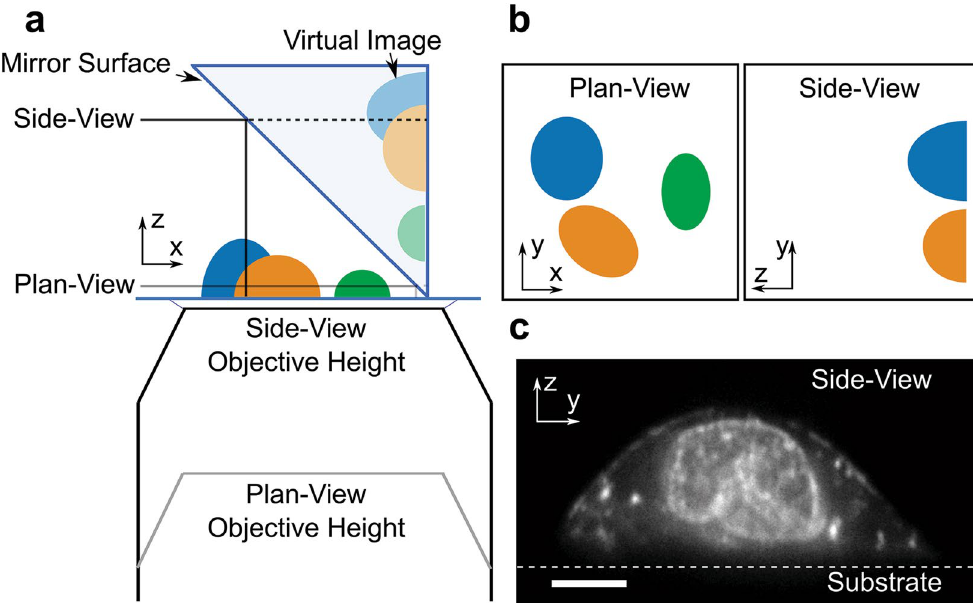
Figure 1. PRISM image formation. ( a ) A cartoon of the PRISM imaging system showing the mirrored surface of the 45-degree reflecting optic, objective, and cells (blue, orange, and green). Both the plan-view and reflected side-view imaging planes are indicated. ( b ) Both the plan- and side-view imaging planes as they would appear in camera view. ( c ) A side view image of an ovarian cancer cell (SKOV3) with both membrane and nucleic acids labeled (Vybrant and SYTO 83 respectively). Scale bar = 5